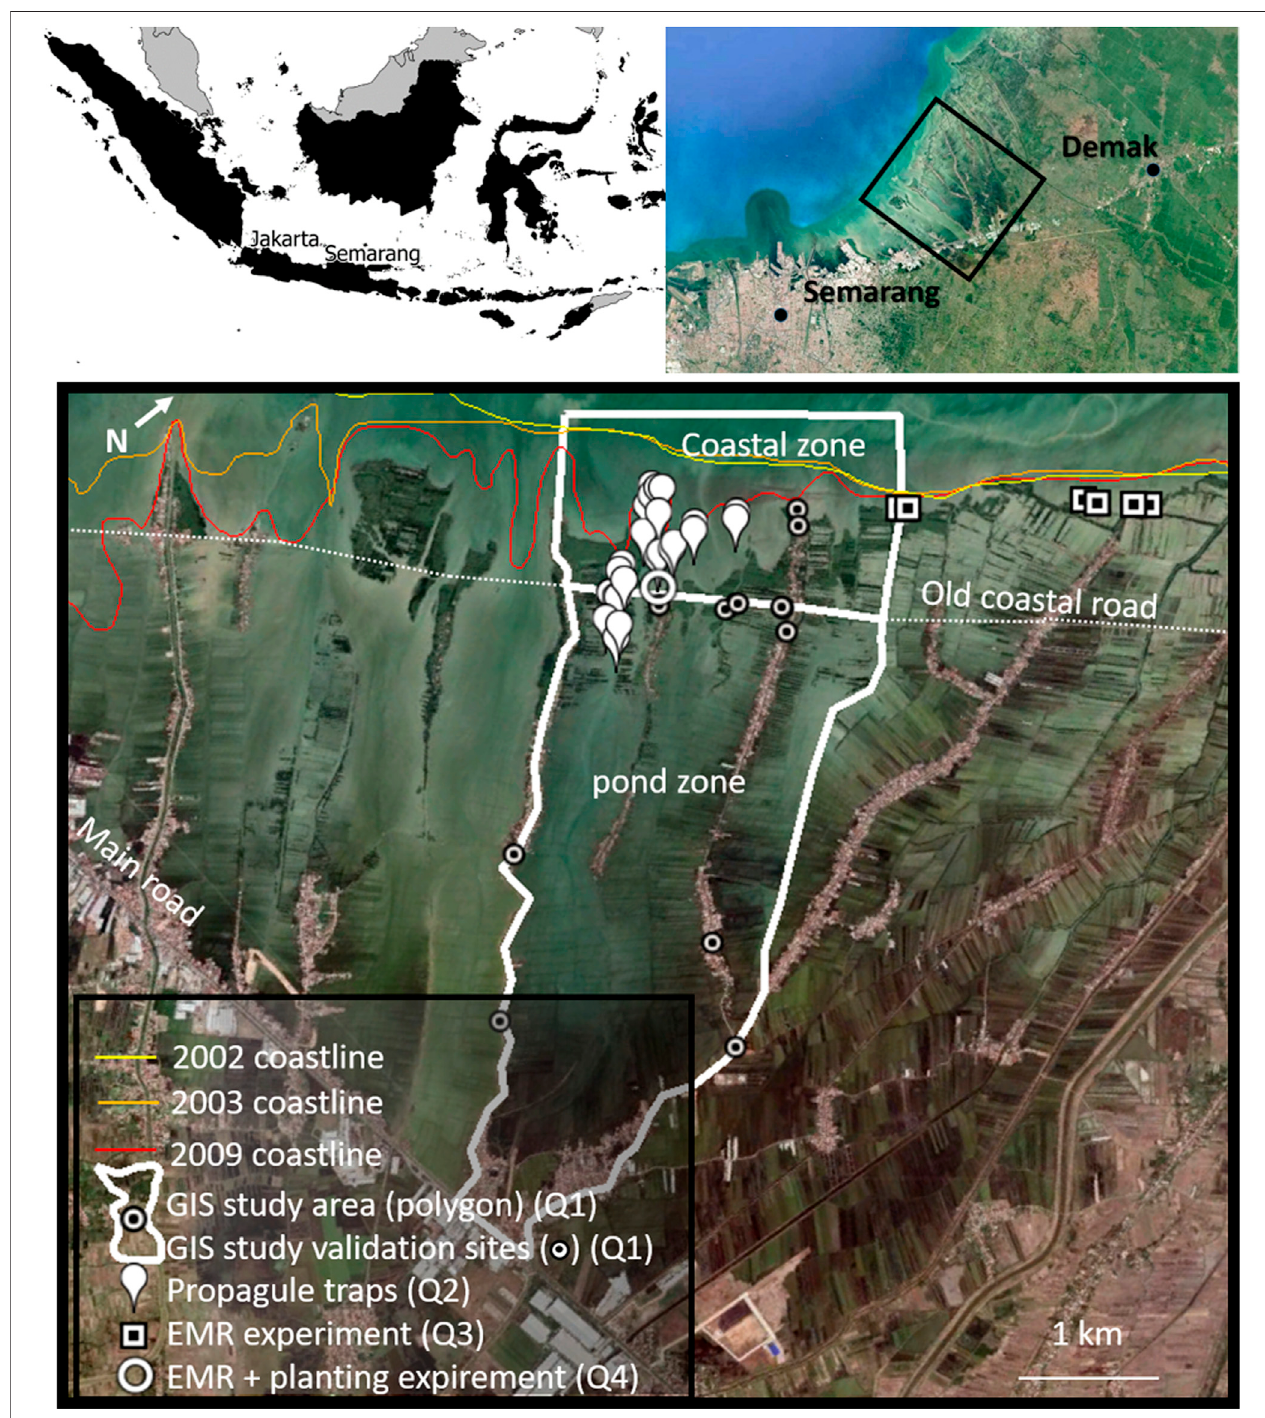
FIGURE 2 | The focus area of this paper, the coastline of Sayung subdistrict (black rectangle) in Demak, Indonesia. Historic coastlines are indicated (before, in between and after two major erosion events), as well as the old coastal road which became the last standing structure resisting coastal erosion, dividing the active aquaculturezonefromthedynamiccoastalzone.Thelocationsofthefourexperimentslinkedtothefourresearchquestionsareindicatedwiththemarksdisplayedinthe legend. Detailed location descriptions and overviews per experiment are shown in the method section.